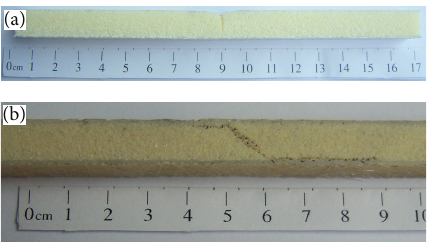
Figure 6: Examples of panels produced after conducting flexural strength test of composites reinforced with (a) fabric and (b)